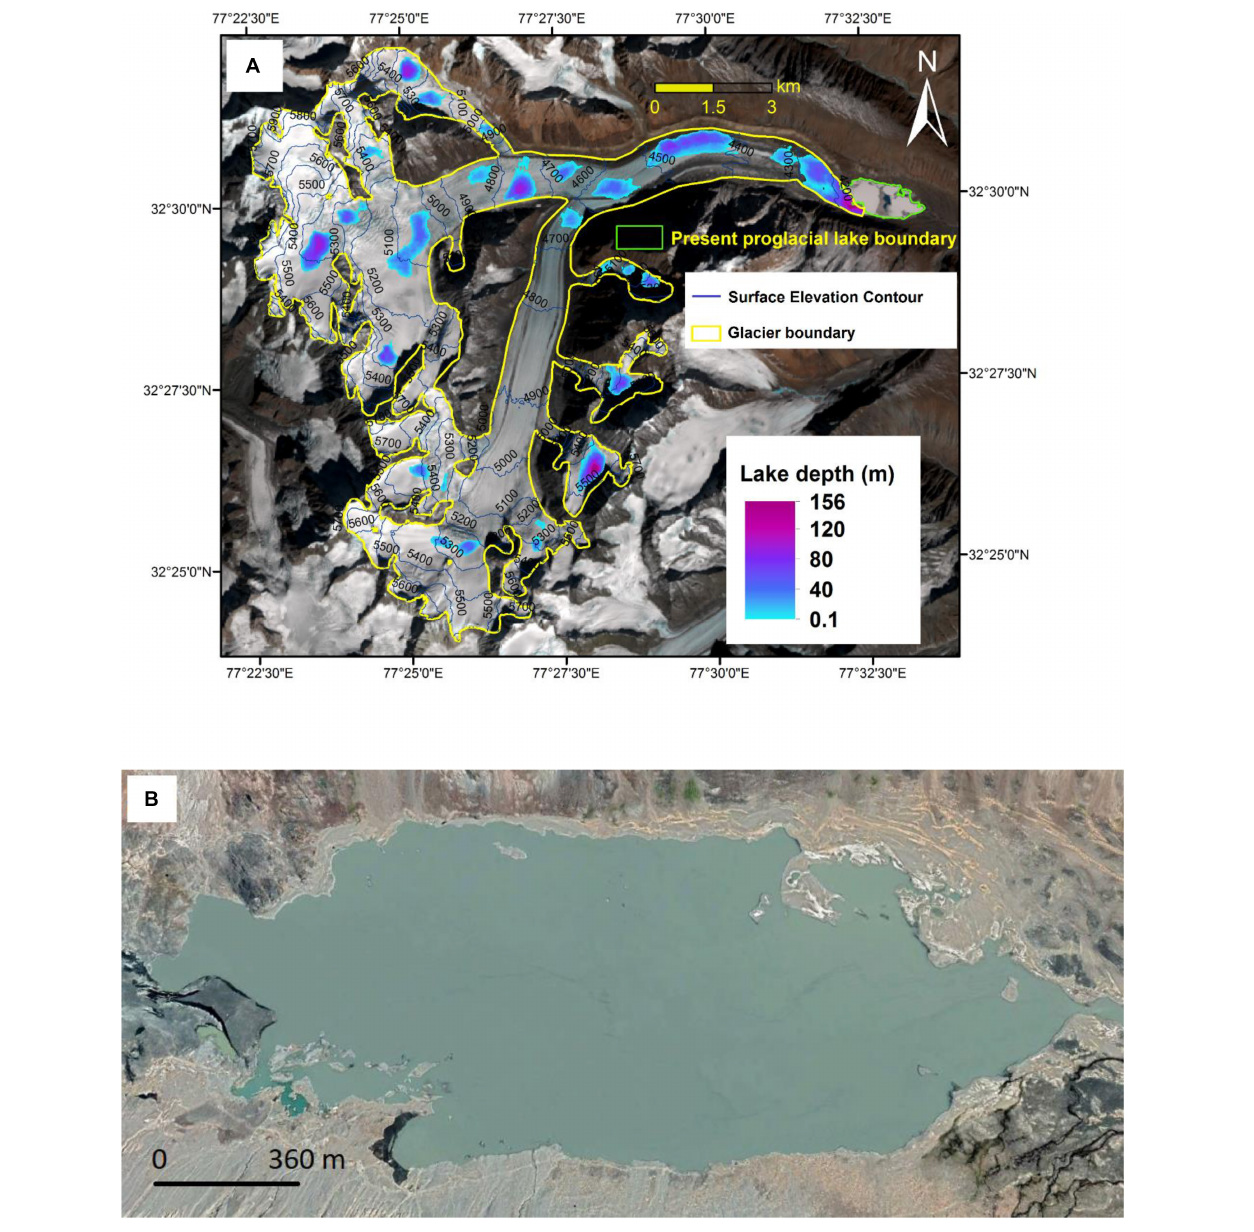
FIGURE 7 | (A) Potential sites for future lake formation in the Samudra Tapu Glacier. Background image: standard FCC of Landsat 8 image acquired on 17 March 2017. (B) Enlarged image of the existing proglacial lake at the Samudra Tapu Glacier (Image source: Google Earth, Sep